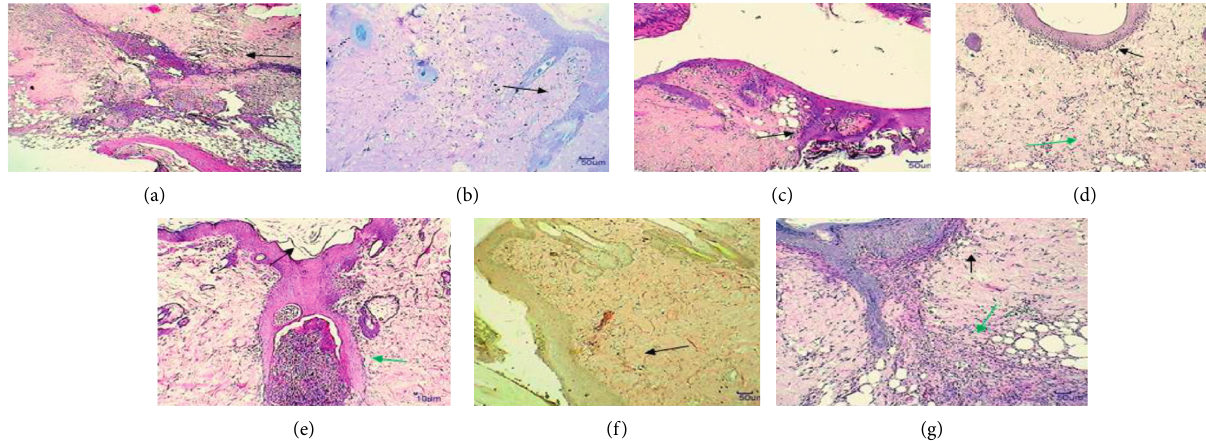
Figure 4: Histopathological indications on immature coconut fiber (monofilament) sutured skin area sections. (a) 24hrs—H and E 10x, necrosis of epidermal and dermal cells with scab formation and severe neutrophilic infiltration. (b) Epithelial cell migration and pro- liferation with severe neutrophilic infiltration. (c) 72 hrs—H and E 10x, mild epidermal proliferation with granulation tissue invasion. (d) 96hrs—H and E 10x, epidermal layer thickening, mild granulation tissue formation. (e) 120 hrs—H and E 10x, severe epidermal kera- tinization, moderate invasion of granulation tissue. (f) 144 hrs—van Gieson 10x, organized collagen proliferation. (g) 168 hrs—PAS 10x, moderate amount of neovascularization, granulation tissue formation.